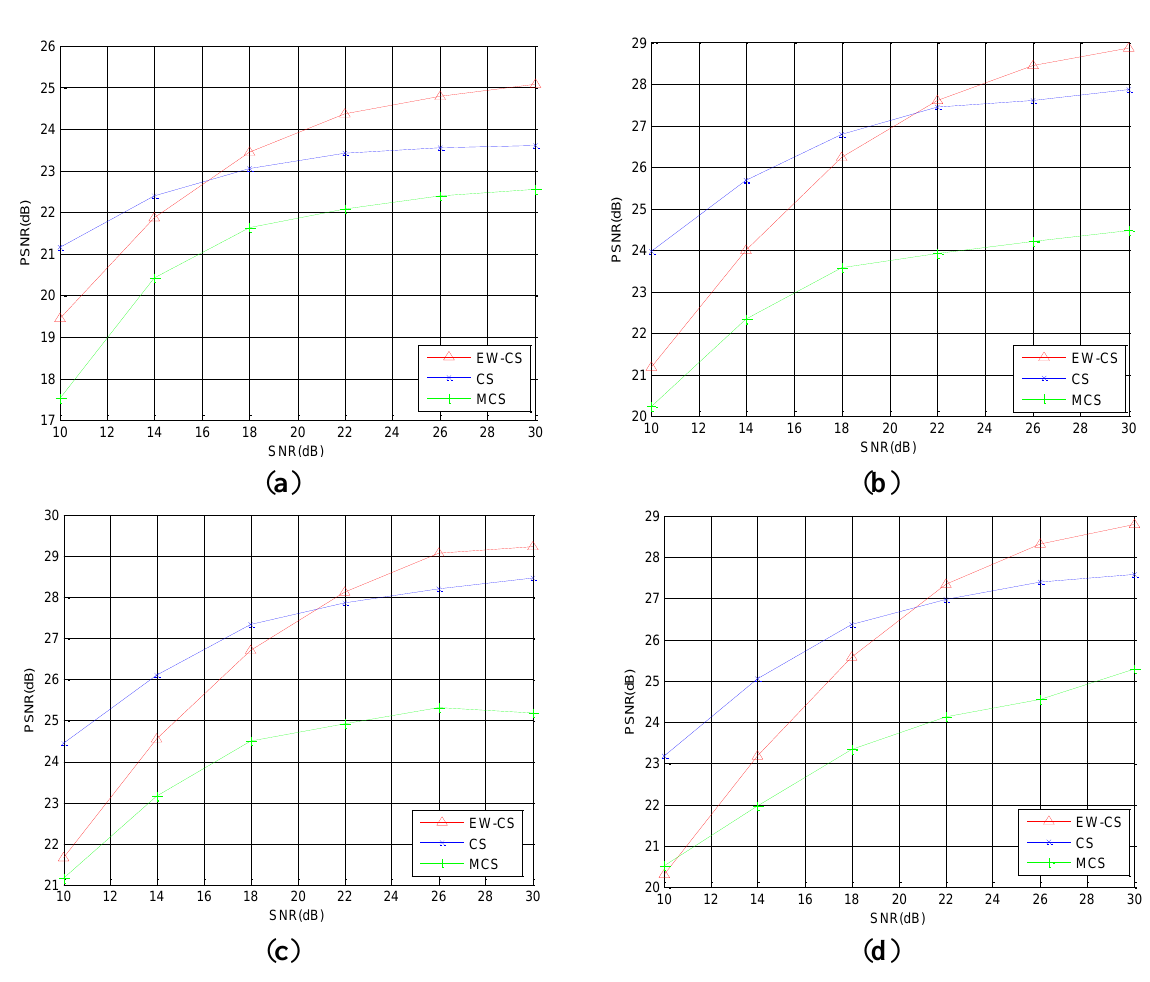
Figure 9. The PSNR performances with different SNR (dB). ( a ) “Aerial”, ( b ) “Boat”, ( c ) “Lena”, ( d )